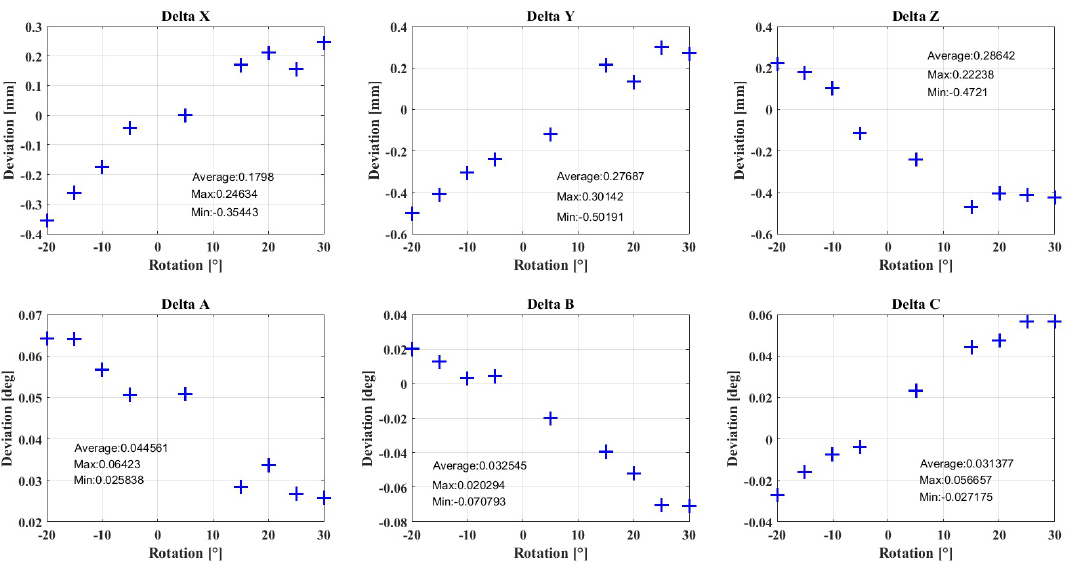
Figure B1. Robot deviations due to rotation around the z -axis ( α